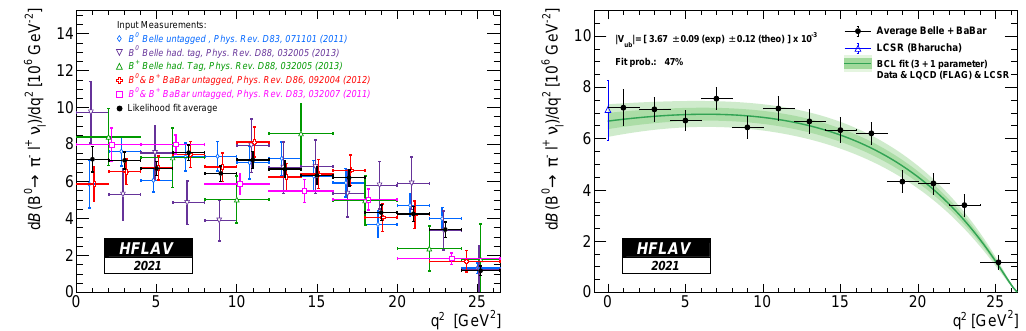
Figure 10: (Left) The measurements entering the likelihood based average from Ref. [ 145,146 ] are shown. (Right) The averaged spectrum can be used to determine | V | ub